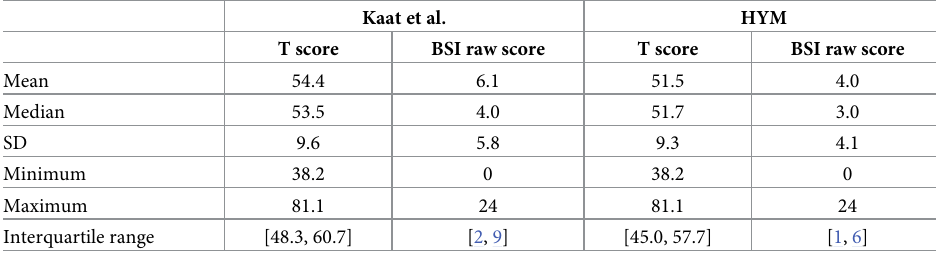
Table 2. Summary statistics for the scores of the BSI Depression and the PROMIS depression. Kaat et